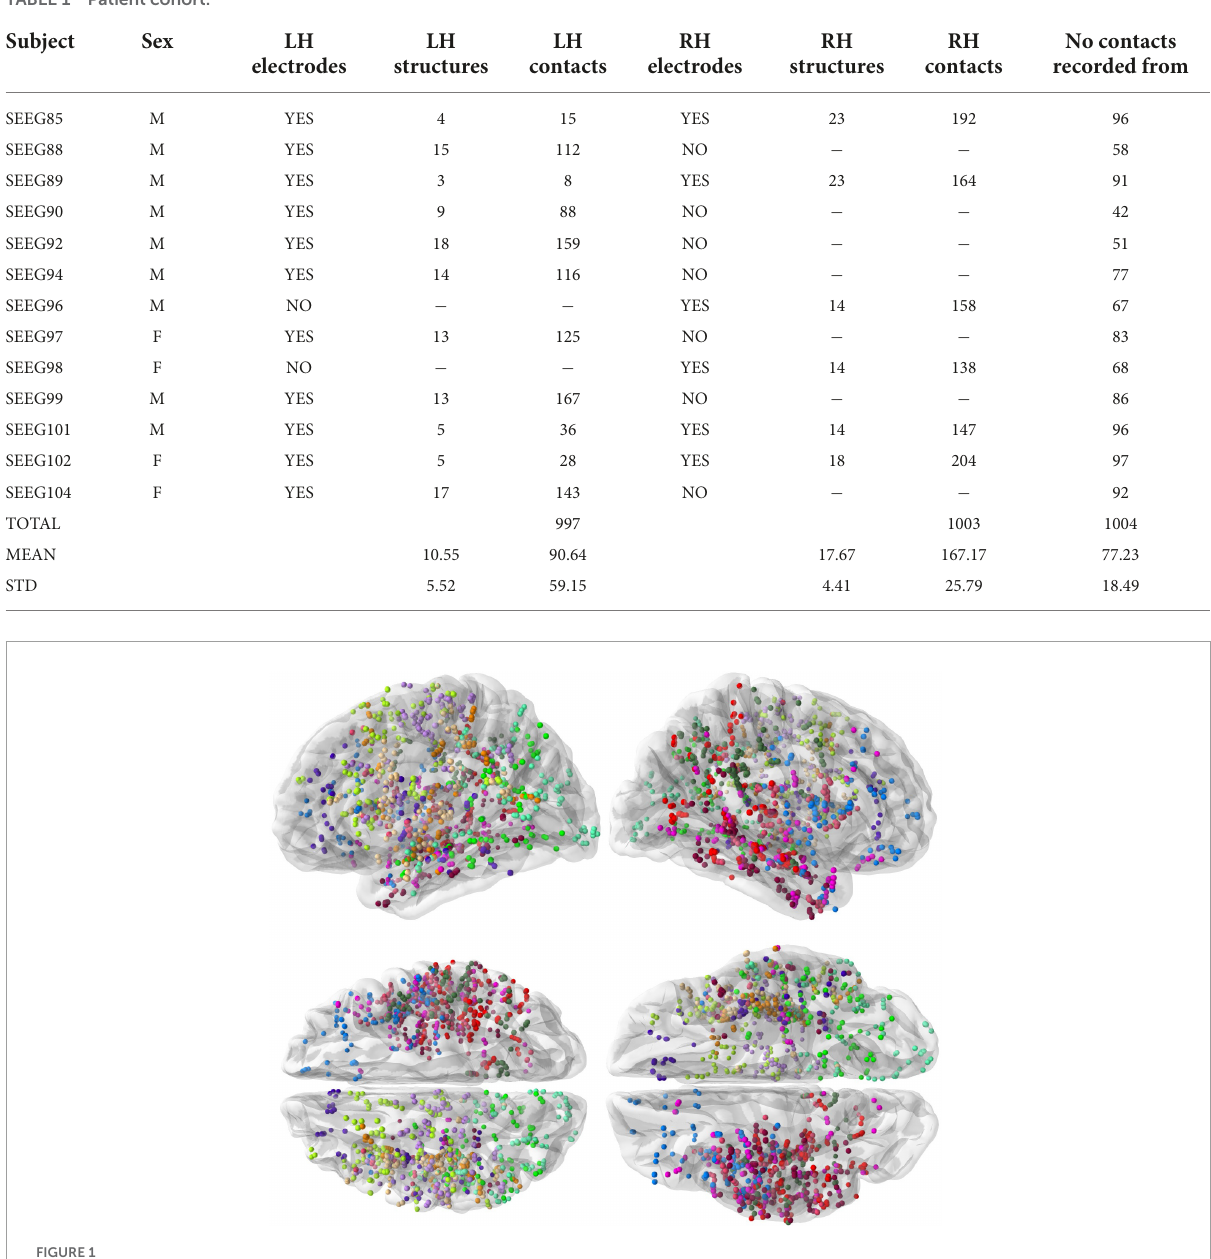
FIGURE1 Spatial coverage of the brain by intracranial electrodes ( top row: left and right hemisphere views, bottom row: dorsal and ventral views). Intracranial electrode contacts of each of the 13 subjects are shown with a different